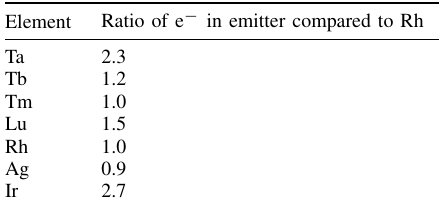
TABLE III G EANT 4 SIMULATION RESULTS SHOWING RATIO OF ELECTRONS PRODUCED IN THE EMITTER TO THAT OF RHODIUM FOR EACH EMITTER CANDIDATE . C ANDIDATES ARE LISTED IN ORDER OF JUDGED SUITABILITY